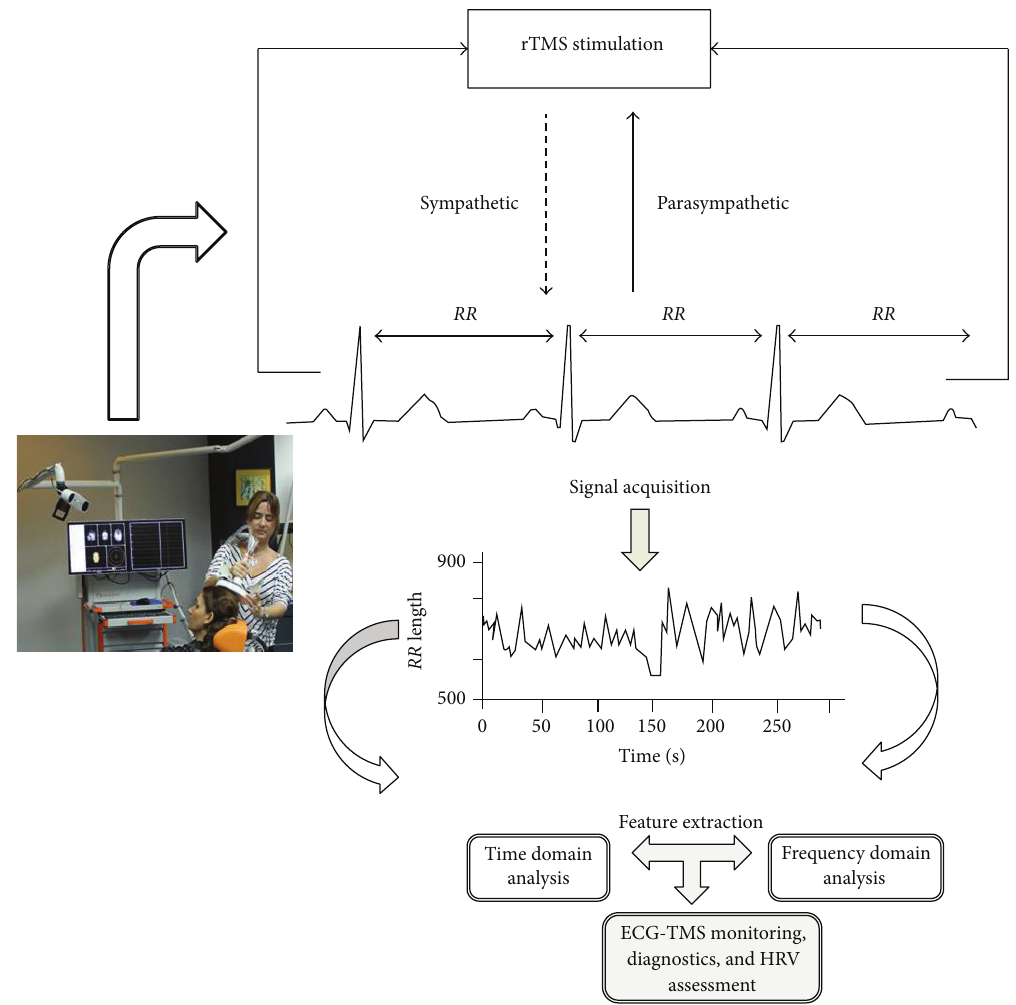
Figure 4: Design structure of the ECG-TMS